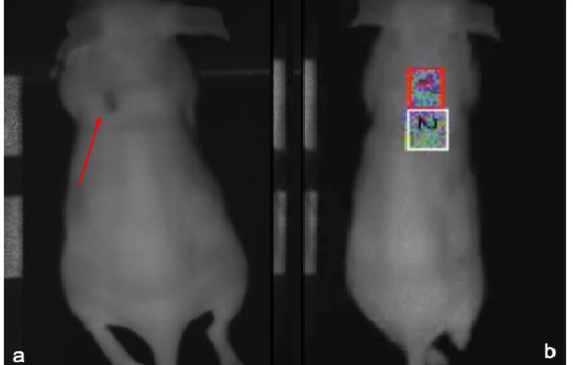
Figure 1. High-definition images captured from laser Doppler flow showing in ( a ) red arrow indicated the radionecrosis area and ( b ) assessment areas over the radionecrosis lesion (red square) and normal skin below (white square).